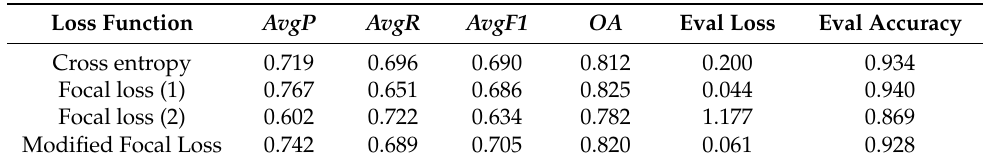
Table 2. The comparison on different loss function